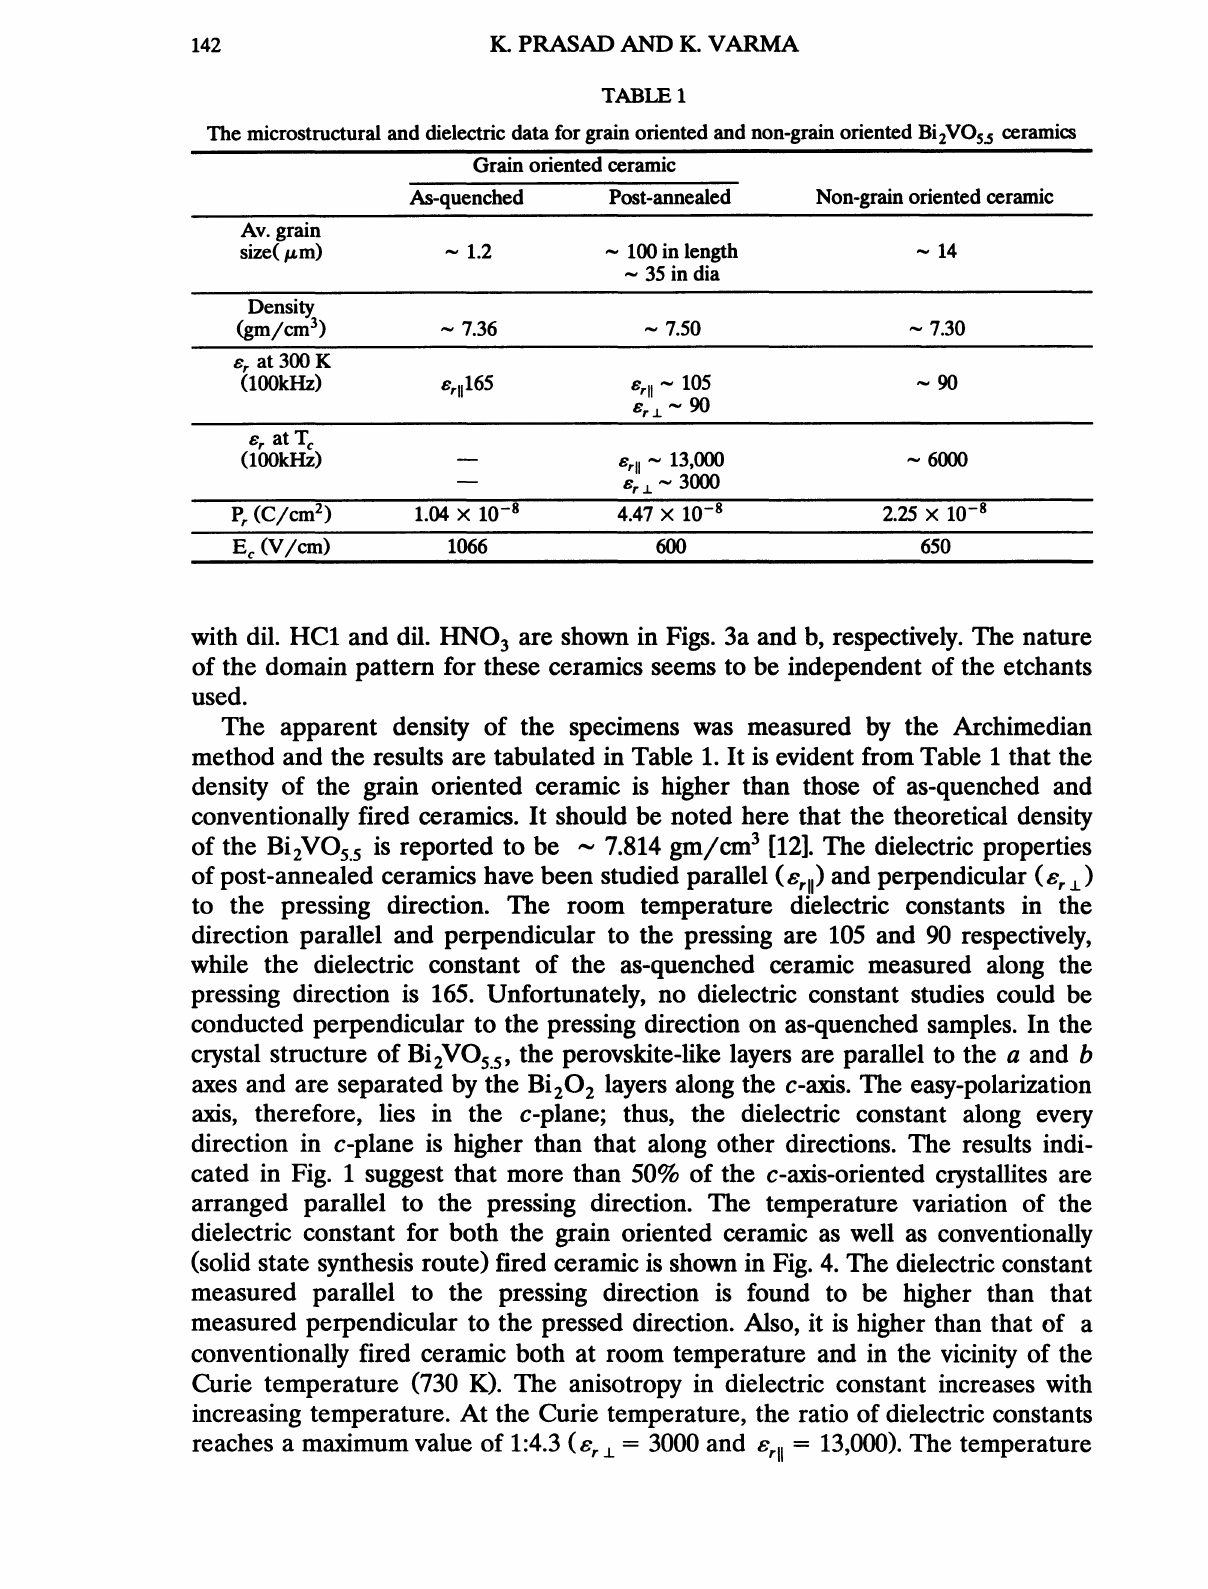
The microstructural and dielectric data for grain oriented and non-grain oriented Bi2VOs ceramics Grain oriented ceramic As-quenched Post-annealed Non-grain oriented